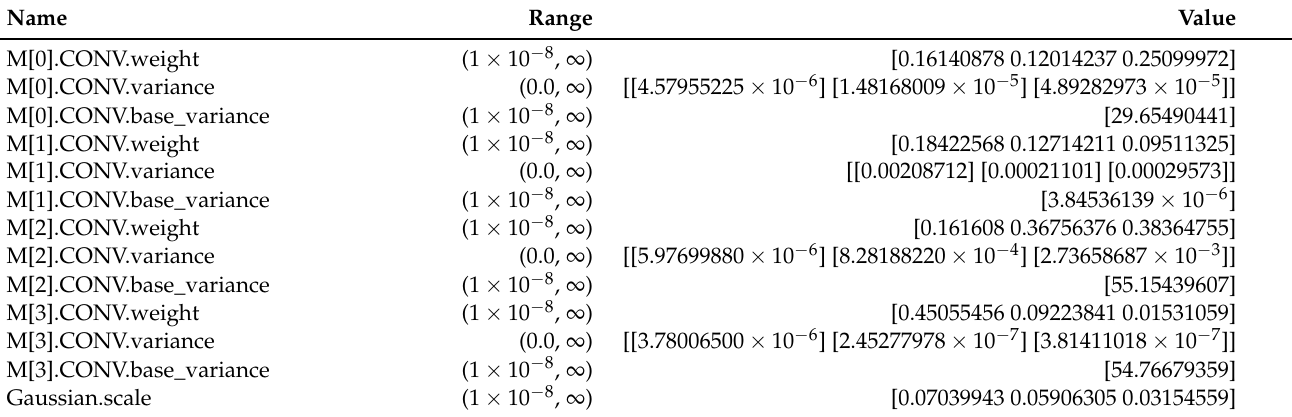
Table A3. Hyperparameters of the MOGP CONV model trained with the S2 GP VWC and S1 RVI orbits 68 and 141 time series over the winter wheat 2020 ROI-1.